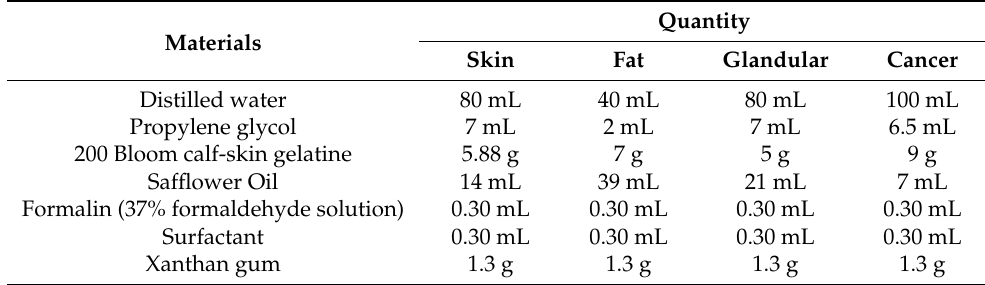
Table 5. Composition of different tissue layers in the breast phantom [49,50].